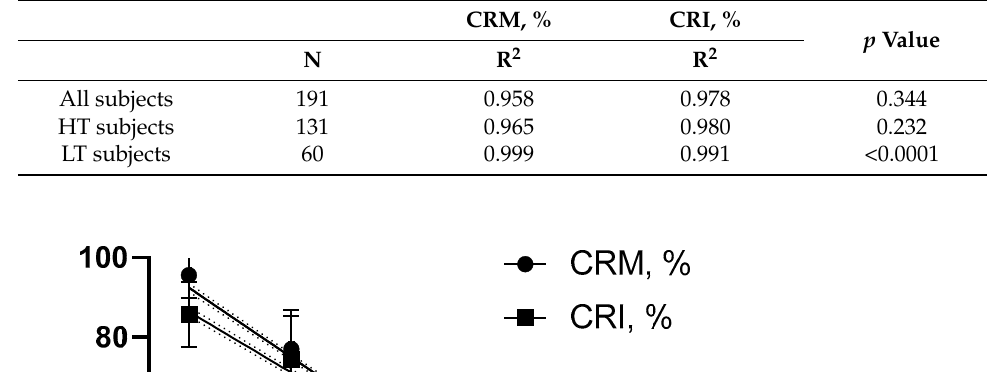
Table 1. Amalgamated correlation coefficients (R 2 ) between LBNP and CRM and CRI for all subjects and those classified as having high (HT) and low (LT) tolerance to central hypovolemia. CRM, %